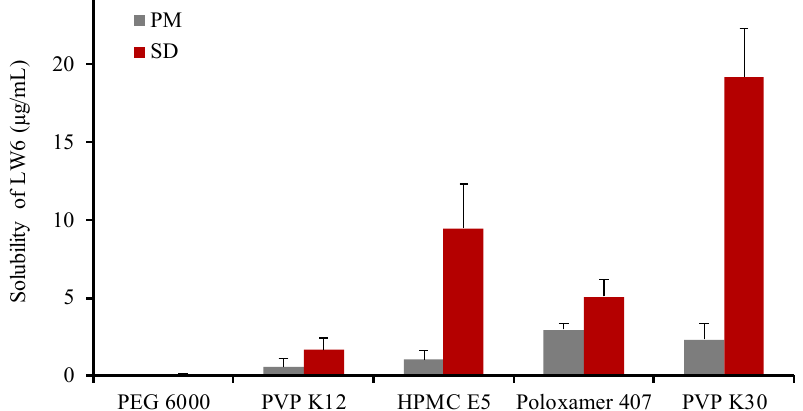
Figure 3. The apparent solubility of LW6 in SDs and physical mixtures (PMs) with different polymers. Data are expressed as the mean ± standard deviation (n = 3).